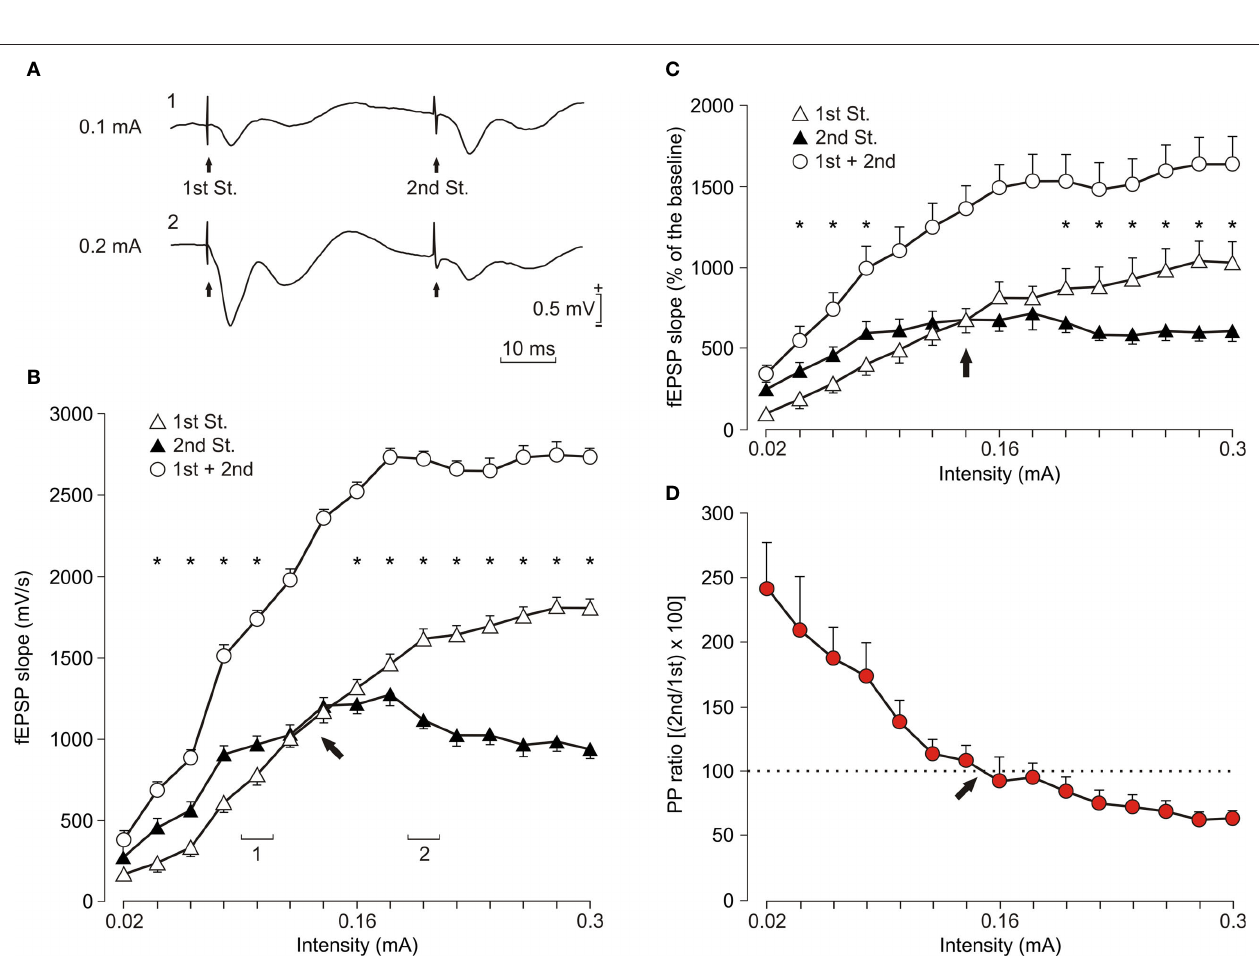
Values for the 1st + 2nd fEPSPs (white circles) are also indicated. These data (illustrated as mean ± SEM) were collected from a representative animal; * P < 0.001 [F = 857.19]. 1 and 2 indicate intensity values for the (14,56) representative records illustrated in (A) . (C) The same as for (B) , but representing data averaged from 10 animals; * P < 0.001 [F = 38.667]. (14,126) (D) Evolution of the paired-pulse ratio [(2nd/1st) × 100; red circles] with increasing stimulus intensity for the data illustrated in (C) . Arrows in (B–D) indicate the intensity at which the PPF was reversed into